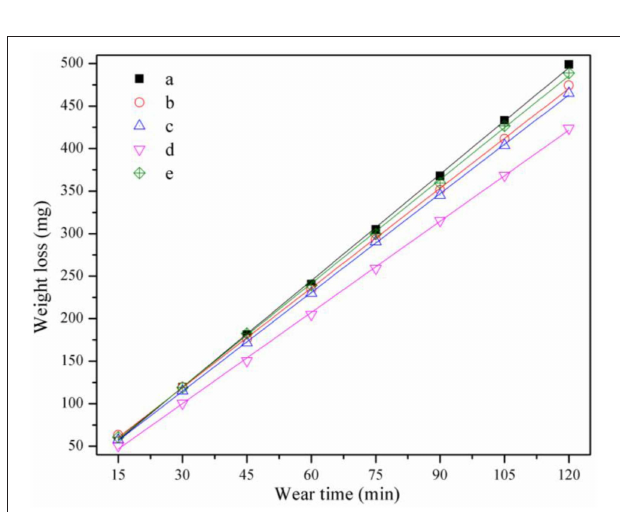
FIGURE 5 | Weight loss as a function of wear time.